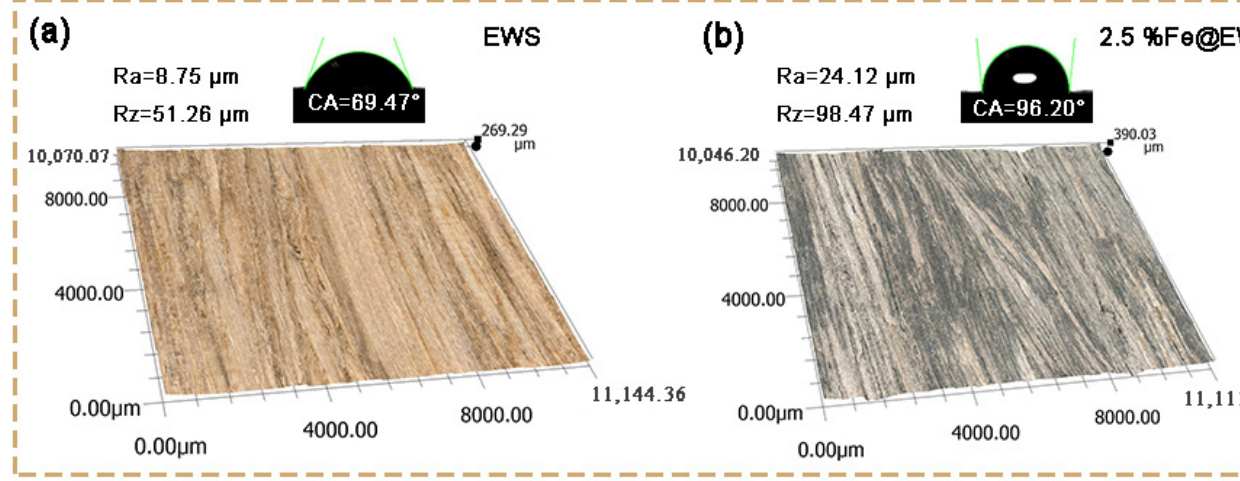
Figure 6. Surface morphologies, roughness, and contact angle of EWS ( a ), 2.5%Fe@EWS ( b ).